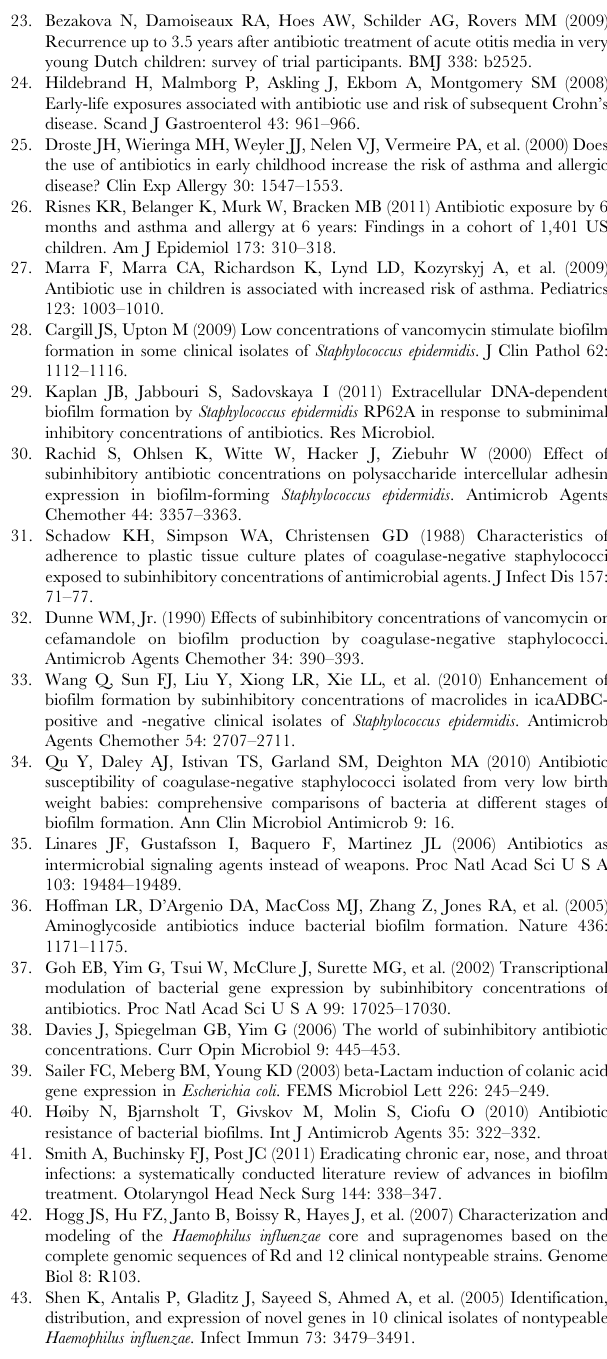
Table S4 Significant gene list with all probe IDs identified by microarray analysis in the PittGG biofilm bacteria (NTHi) exposed to 170 ng/mL